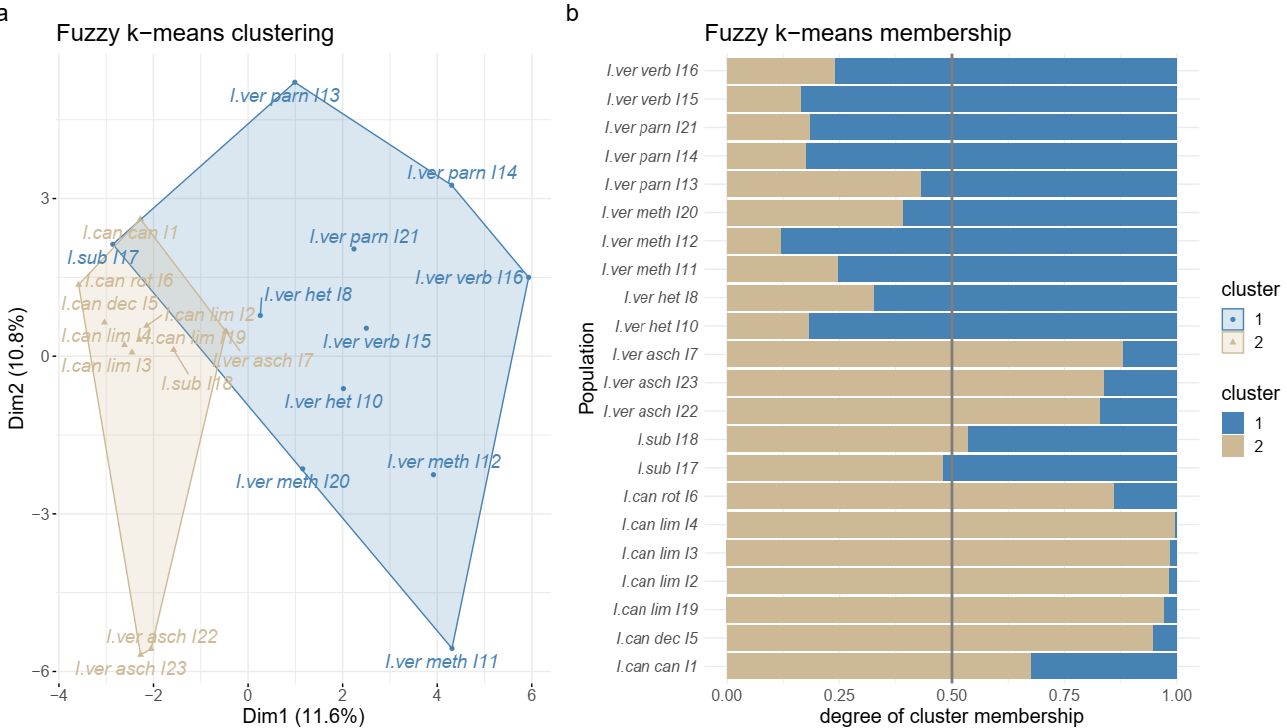
Figure 1. ( a ) Classification of each Inula population based on the fuzzy k-means clustering algorithm. Blue color refers to cluster 1 (mainly I. verbascifolia ) and brown color refers to cluster 2 (mainly I. candida ). ( b ) Degree of membership of each population based on the fuzzy k-means clustering algorithm. Population I9 ( I. verbascifolia subsp. heterolepis ) has the least number of compounds identified and was excluded from several analyses.